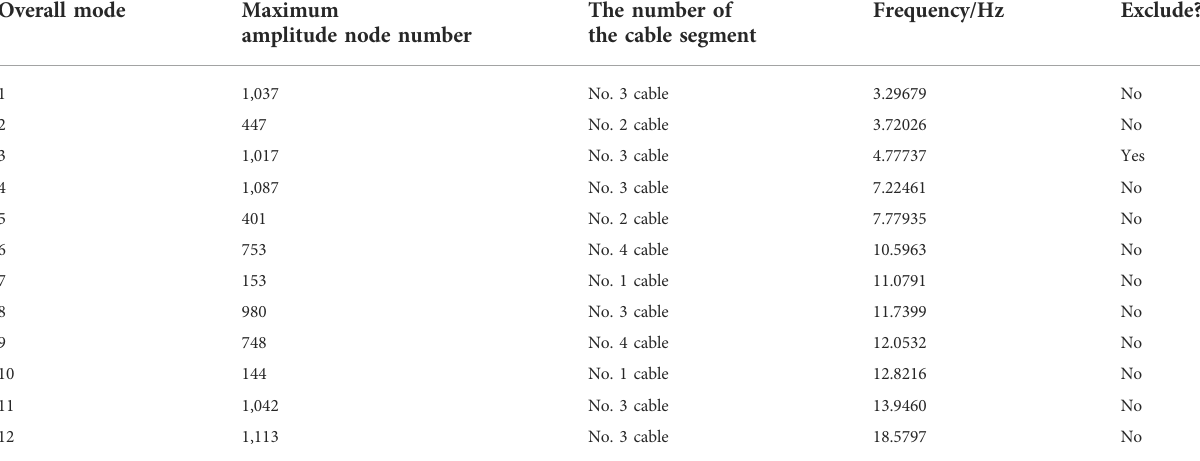
TABLE 1 Overall modal information and corresponding cable segment number.